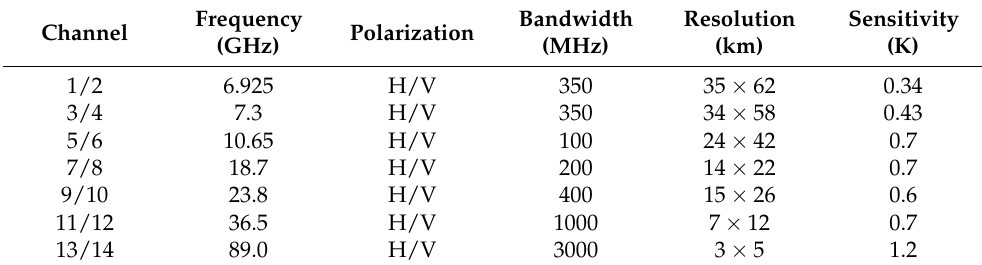
Table 1. AMSR2 characteristics and